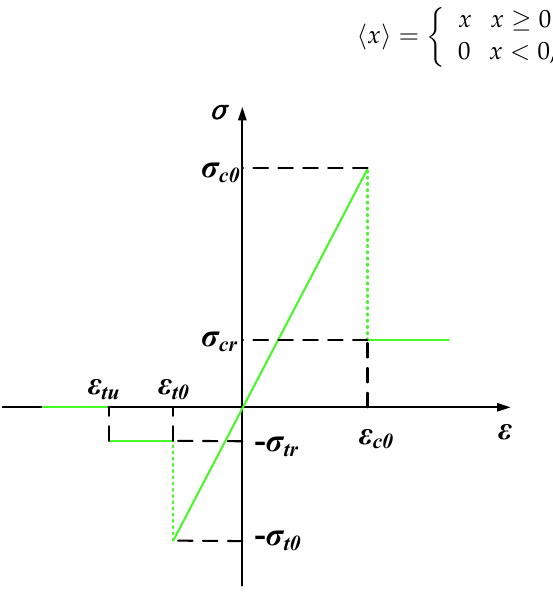
Figure 1. Elastic–brittle damage constitutive law of elements.